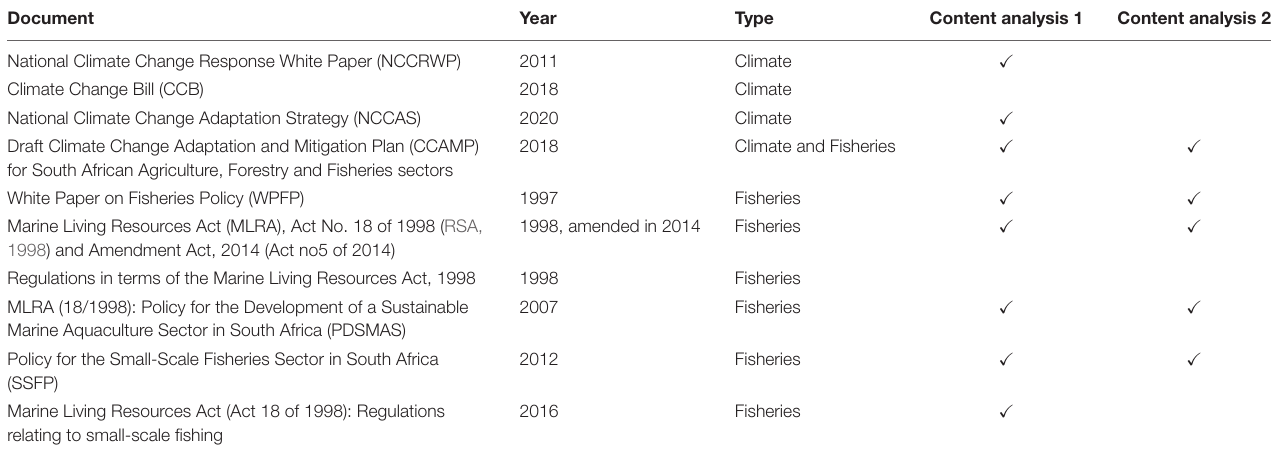
TABLE 3 | List of climate and fisheries documents included in the analysis. Document